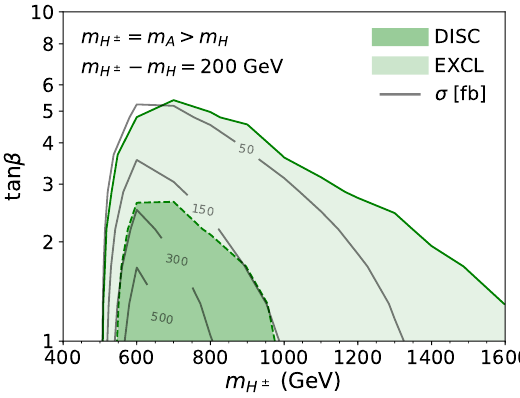
Figure 3 . The 95% C.L. exclusion (region enclosed by solid green line) and 5 σ discovery (region enclosed by dashed green line) reach of the exotic charged Higgs at future 100 TeV pp collider with L = 3000 fb − 1 through H ± → HW ± → t ¯ tW ± channel in the m m A = m = m H + 200 GeV. The total production cross sections for the dilepton signal are H ± indicated by the gray